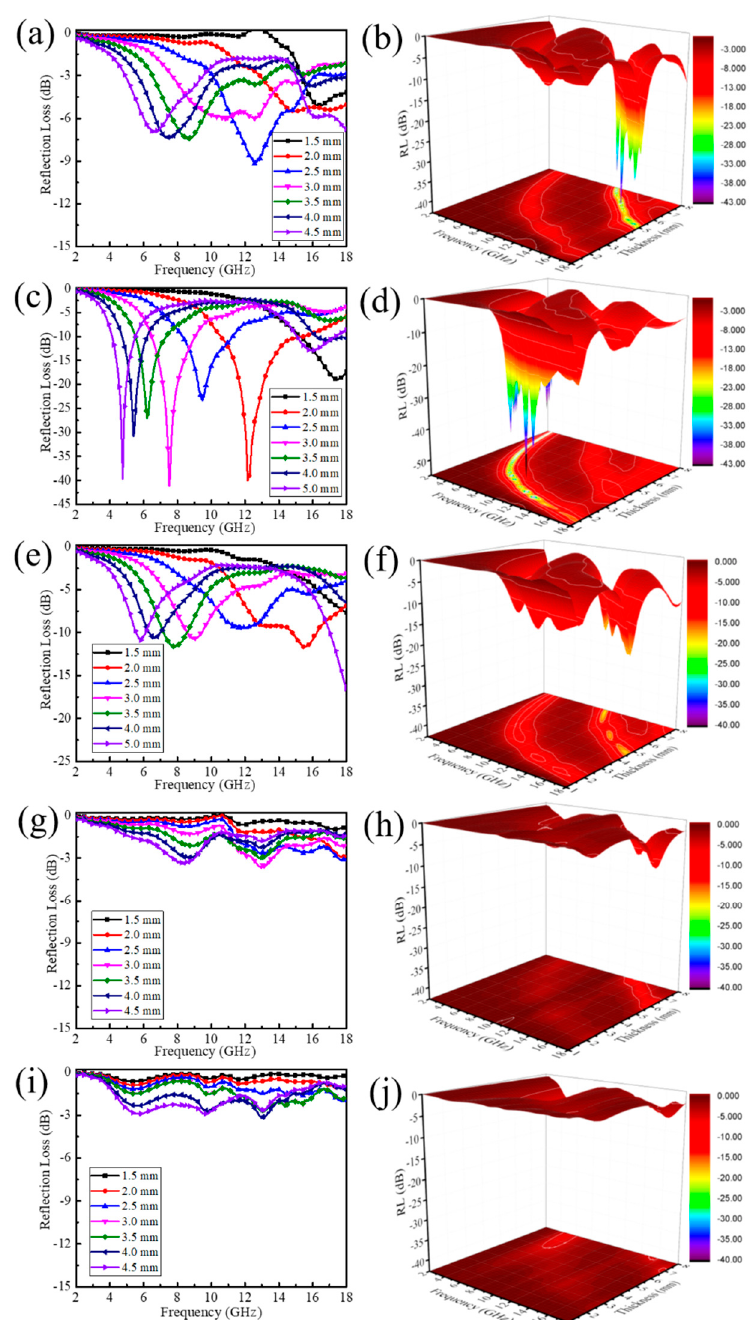
Figure 4. Reflection Loss curves and 3D plot of B,N-CNT-1 ( a , b ), B,N-CNT-2 ( c , d ), B,N-CNT-3 ( e , f ), B,N-CNT-4 ( g , h ), and B,N-CNT-5 ( i , j ) with a mass percentage of 10 wt% in wax.